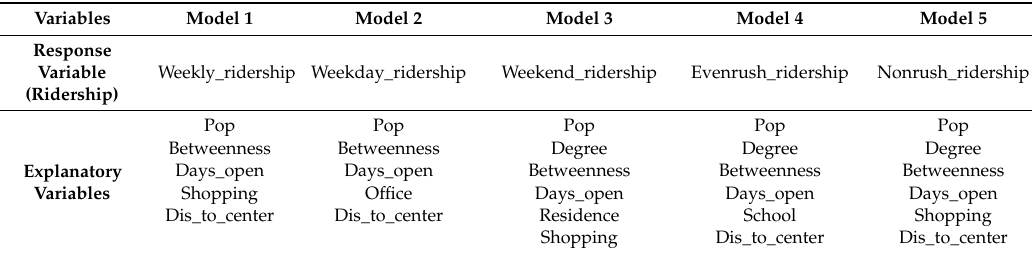
Table 4. Variables selected in the